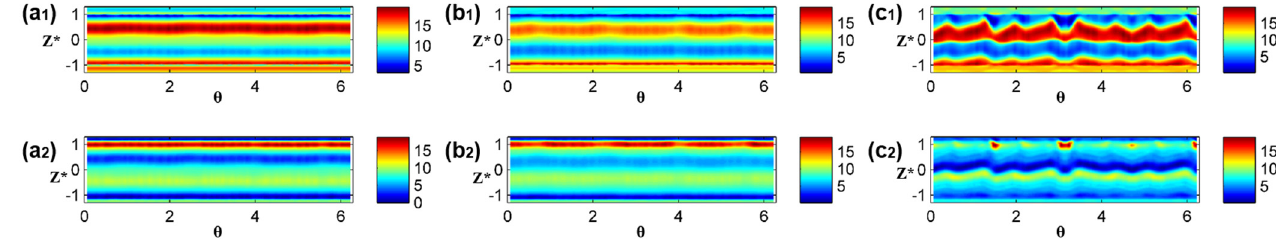
Figure 11. Cloud image of intensity distribution of spiral vortices. ( a 1 , b 1 , c 1 ) are 10 μ m to the lateral wall of the rotor; ( a 2 , b 2 , c 2 ) are 10 μ m to the lateral wall of the cavity; ( a ) Re = 1.75 × 10 3 ; ( b ) Re = 1.75 × 10 4 ; ( c ) Re = 7.02 × 10 4 .